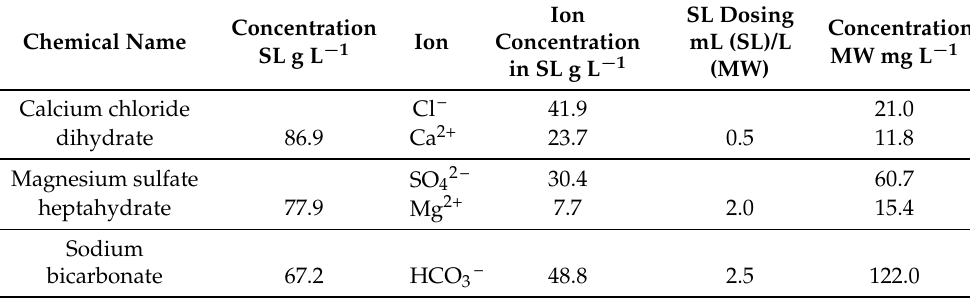
Table 4. A. Base model water (MW) and test water for hardness low—Experiment no.1.